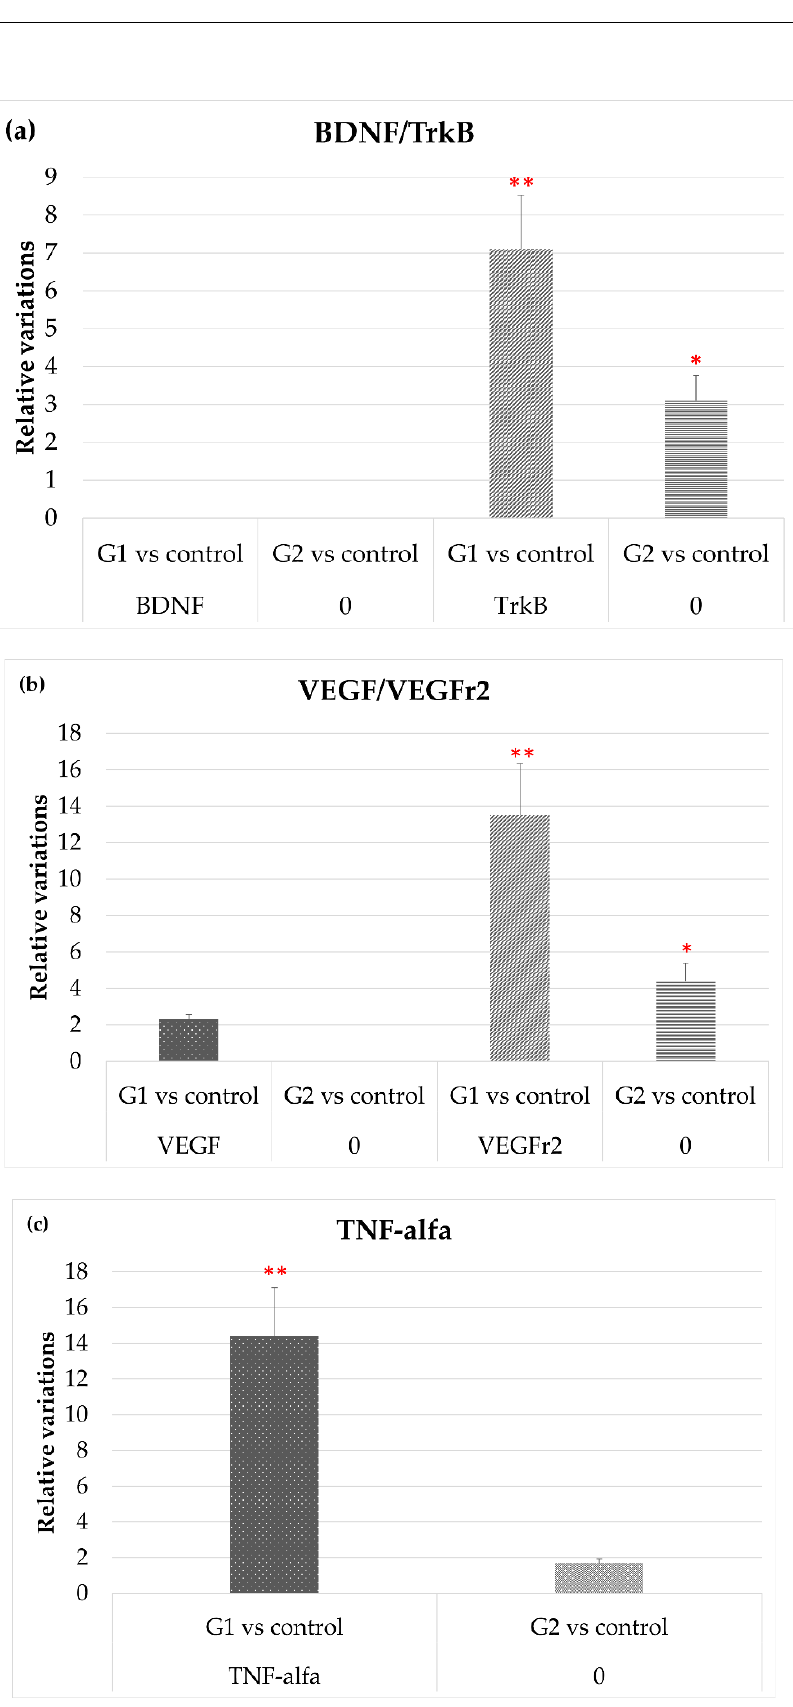
Figure 5. Variation of the expression in both experimental vs. control groups, of ( a ) TrKB; ( b ) VEHG and VEGFr2; and ( c ) TNF- α. * p < 0.05; ** p < 0.01.